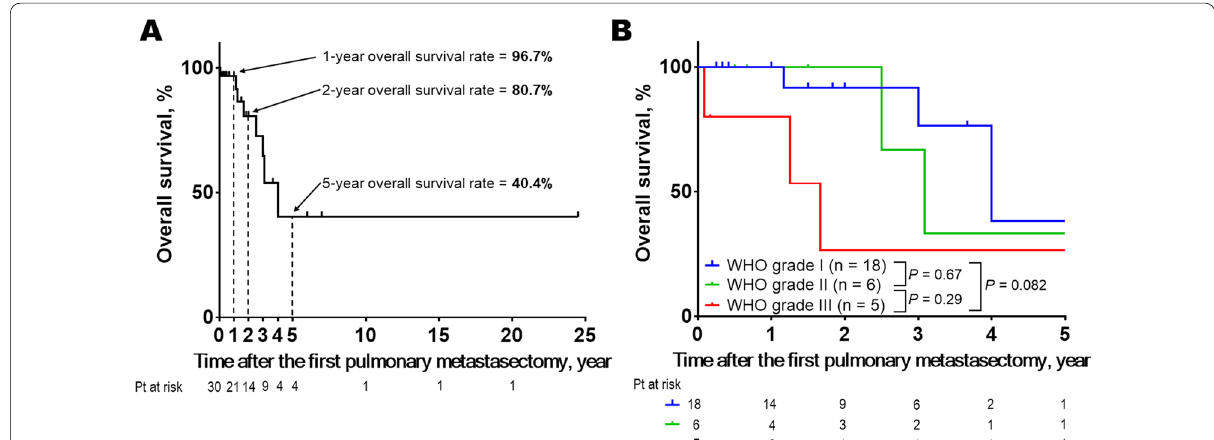
Fig. 4 Overall survival after the first pulmonary metastasectomy for lung metastasis of cranial meningioma based on the integration of the reported cases ( n 30) [5, 6, 15, 17–38]. a The 1-, 2-, and 5-year overall survival rates based on the integration of all reported cases ( n = 96.7%, 80.7%, and 40.4%, respectively. b WHO grade III meningioma was more likely to be associated with worse overall survival than WHO grade I meningioma ( P 0.082). The overall survival did not significantly differ between patients with WHO grade I and II meningioma ( P = between patients with WHO grade II and III meningioma ( P 0.29, =